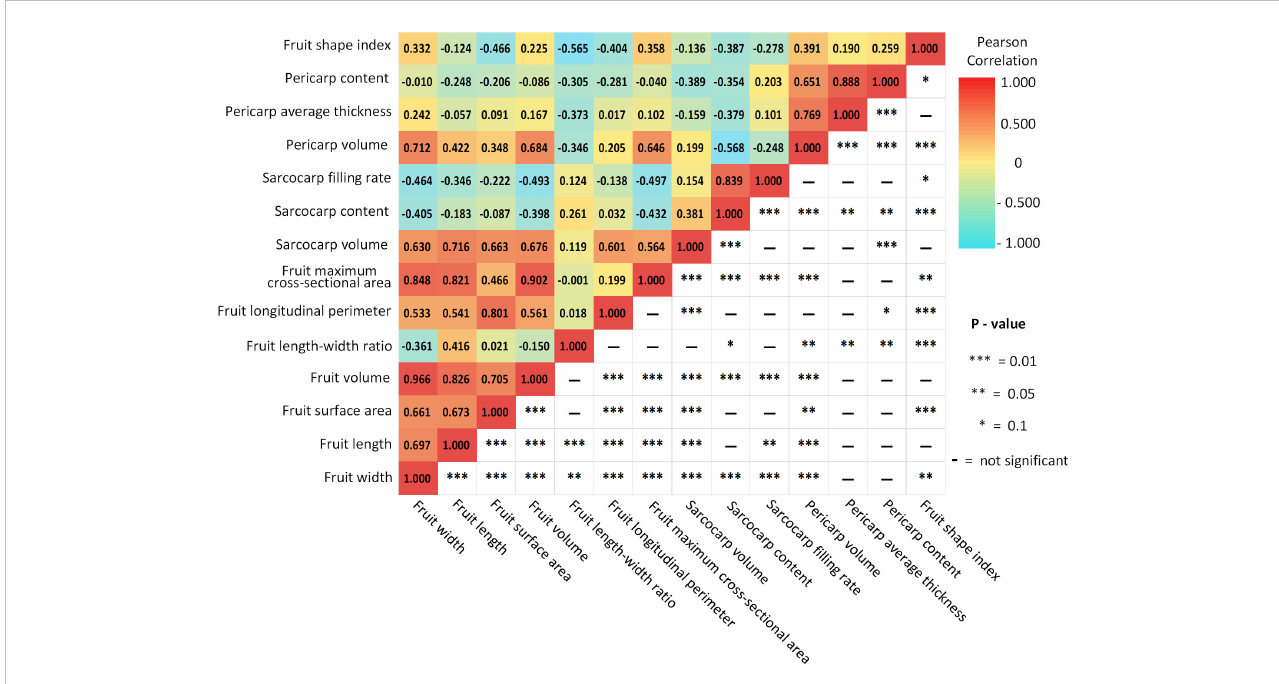
FIGURE 10 Pearson correlation matrix for passion fruit morphological traits.